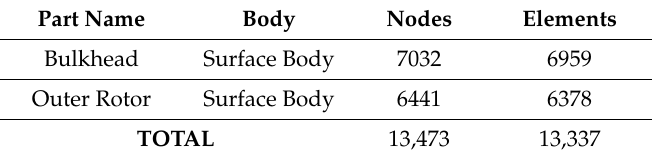
Figure 16. Finite element modeling and mesh of magnet coupler. Table 3. Number of Nodes and Elements for the Bulkhead and Outer Rotor. Table 4. Physical properties of the magnetic coupler (bulk head and outer rotor).